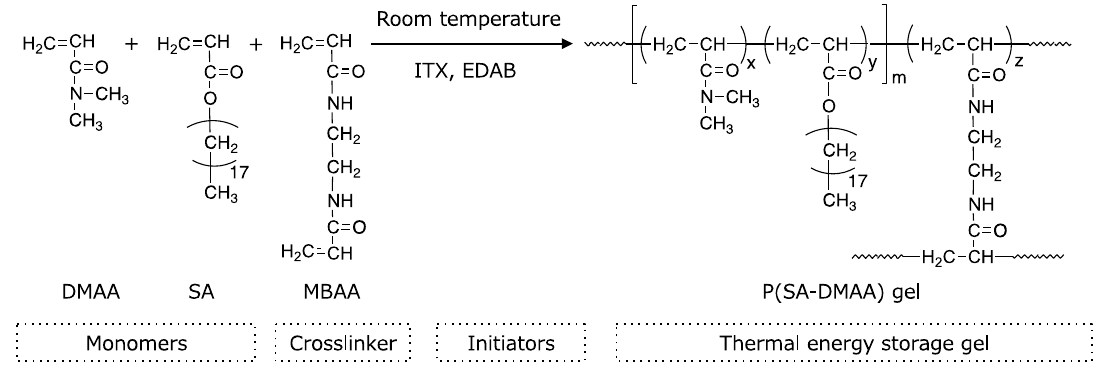
Figure 1. Synthesis scheme of the thermal energy storage crystalline P(SA-DMAA) gel. A light-induced random polymerization is processed between phase change monomer SA and another vinyl monomer DMAA with crosslinker MBAA at the aid of co-initiator system ITX-EDAB.